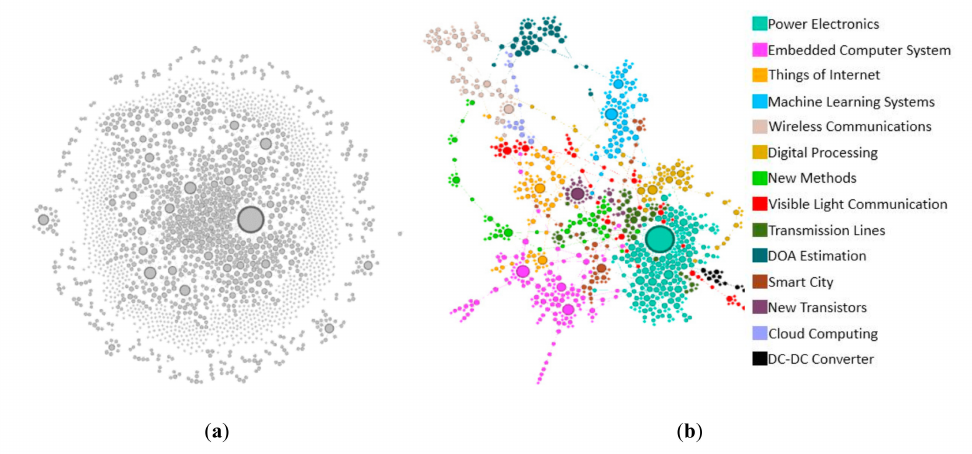
Figure 7. Representations for the node relationships. ( a ) Total node graph. ( b ) Node without citations filtered and colored